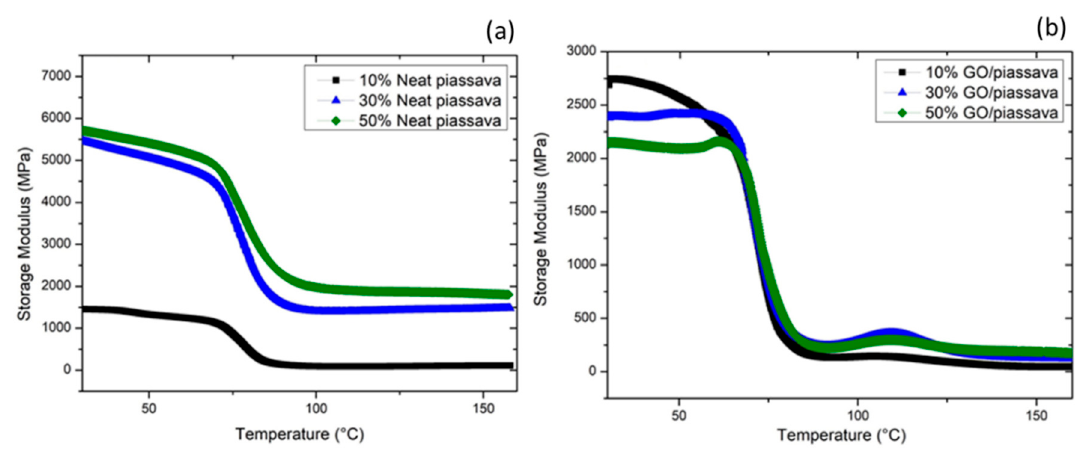
Figure 9. Dynamic modulus behavior for different amounts of ( a ) neat piassava fibers and ( b ) GO-coated piassava fibers. Adapted from [40].